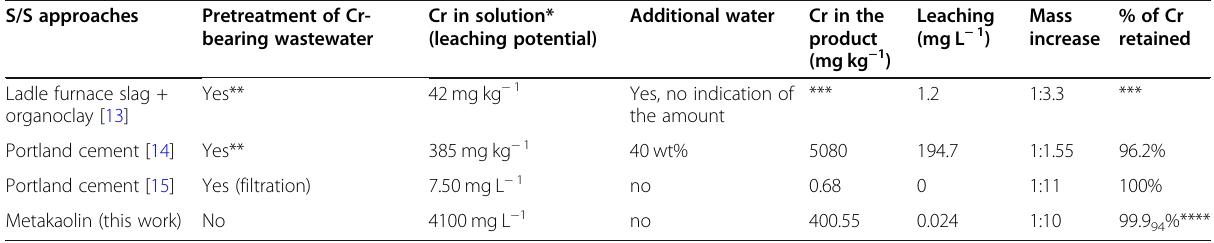
Table 3 *Leaching potential = Cr released from the sludge without S/S treatment. ** These studies collect the sludge after the Cr precipitation process. ***No quantification on the amount of water used nor on the exact amount of chromium in the sludge. ****The value is presented with more significant figures to allow a better comparison